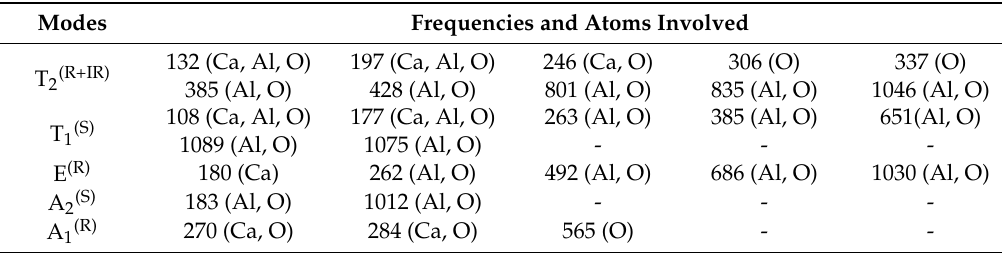
Table 2. The calculated optical phonon frequencies (cm − 1 ) of vibration modes and the atoms involved in the vibrations at point G in the first Brillouin